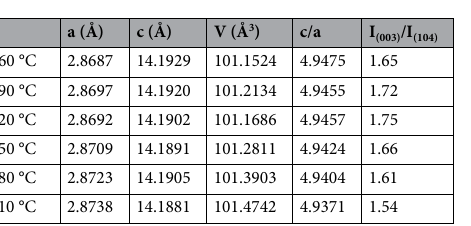
Figure 2. Reitveld refinement results of NCA sintered at ( a ) 660 °C, ( b ) 690 °C, ( c ) 720 °C, ( d ) 750 °C, ( e ) 780 °C and ( f ) 810 °C.